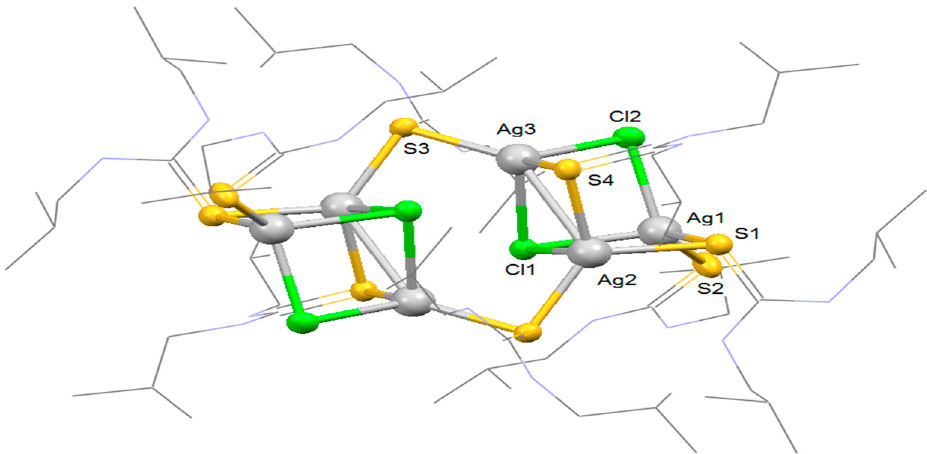
Figure 10. Molecular structure of silver cluster, complex 3 . Only Ag, S and Cl atoms are labeled for an asymmetric unit, thermal ellipsoids are drawn at 40% probability level, hydrogen atoms are omitted and bonds connecting N and C are represented by wireframes for simplicity.